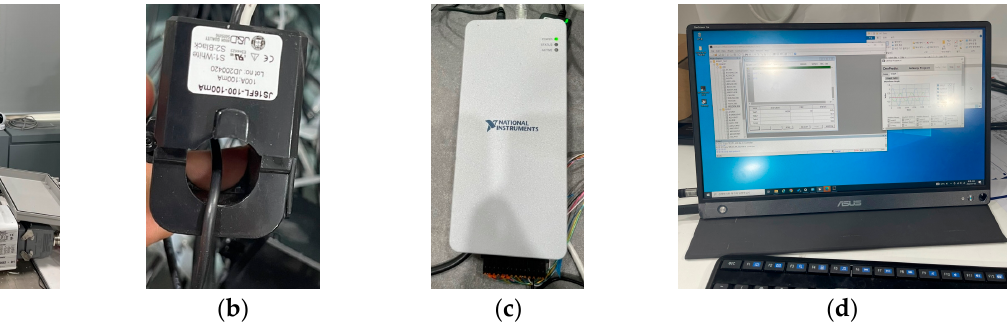
Figure 7. ( a ) Used servo motor in the robot arm; ( b ) faulty servo motor with an inner race bearing fault.